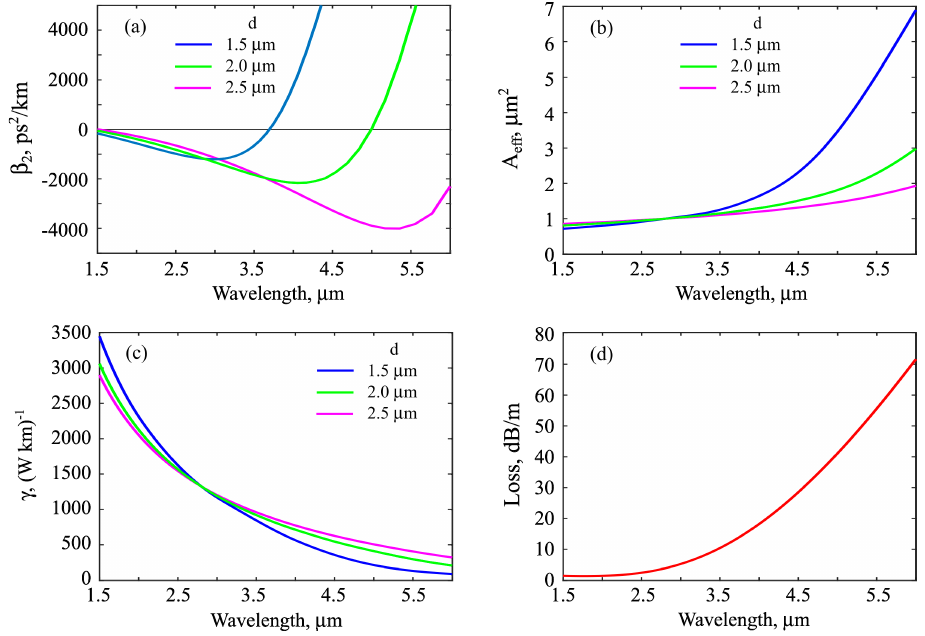
Figure 6. Calculated GVDs ( a ), effective mode field areas ( b ), and nonlinear coefficients ( c ) as a function of wavelength for MS fibers with diameters d = 1.5, 2, and 2.5 μ m. ( d ) The modeled loss function used in numerical simulation of pulse conversion.